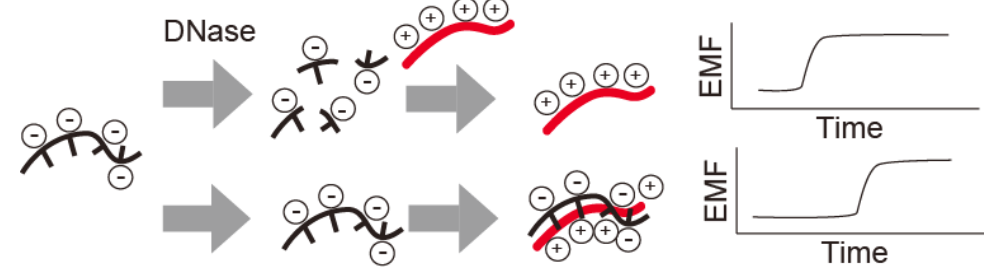
Figure 5. Nuclease detection with a polycation-sensitive membrane electrode based on the electromotive force (EMF) difference in the complexed polycationic polymer and DNA before and after digestion with DNase I.